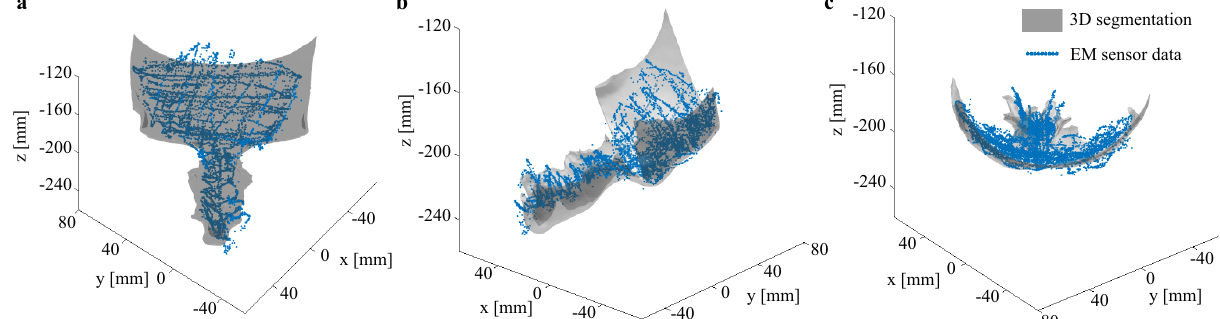
Figure 8. Matching of the 3D segmentation obtained from the cadaver’s head CT scan and the data obtained from manual scanning of the cadaver’s head forehead and nose skin using an EM sensor using the pcregistericp() function of Matlab. ( a ) frontal view; ( b ) lateral view; ( c ) top